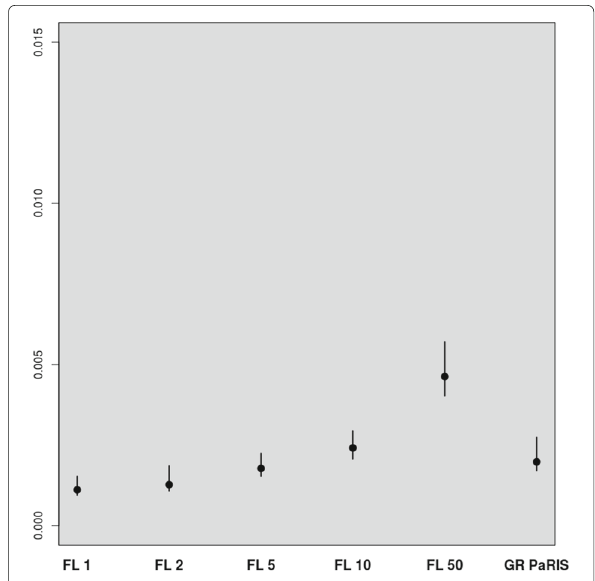
Fig. 10 Log-growth model - variance. Distribution of the empirical absolute coefficient of